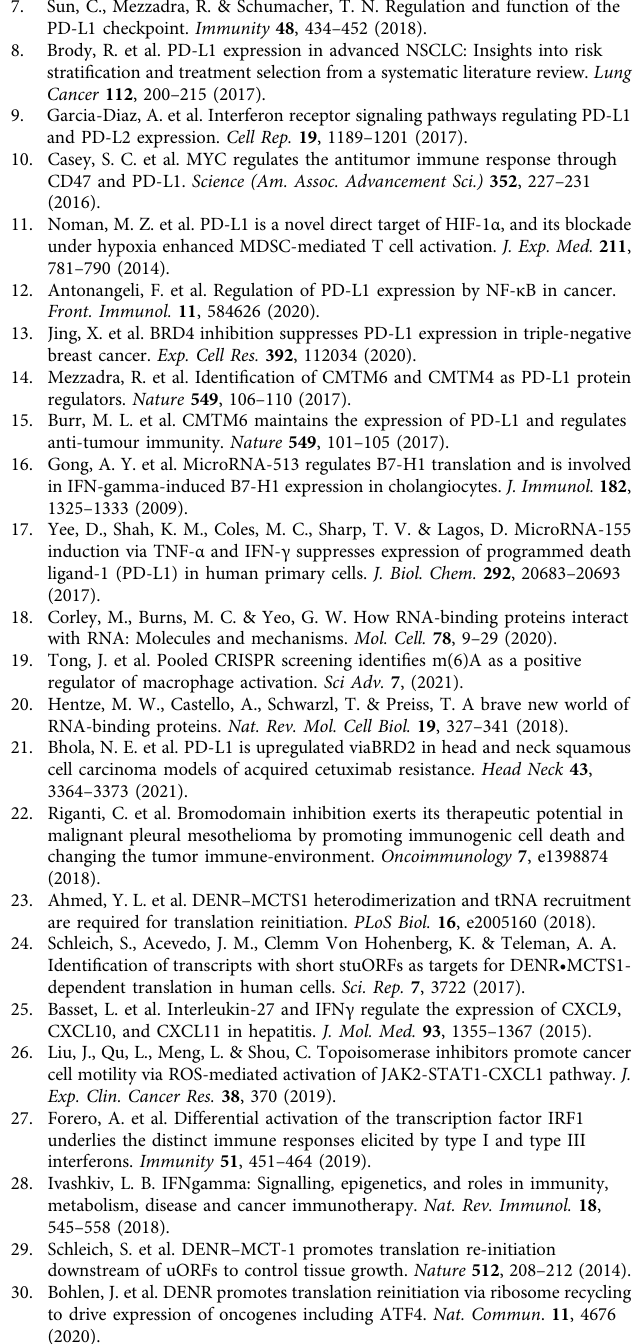
Fig. 7 DENR depletion enhances the anti-tumor killing ability of CD8 + T cells. a , b Control or DENR KO MC38 cells with or without expression OVA were co-cultured with OT-1 CD8 + T cells at an effector (E) to target (T) ratio of 0:1, 3:1, or 5:1 for 16 h; anti-PD-1 (10 µ g/ml) was added as a